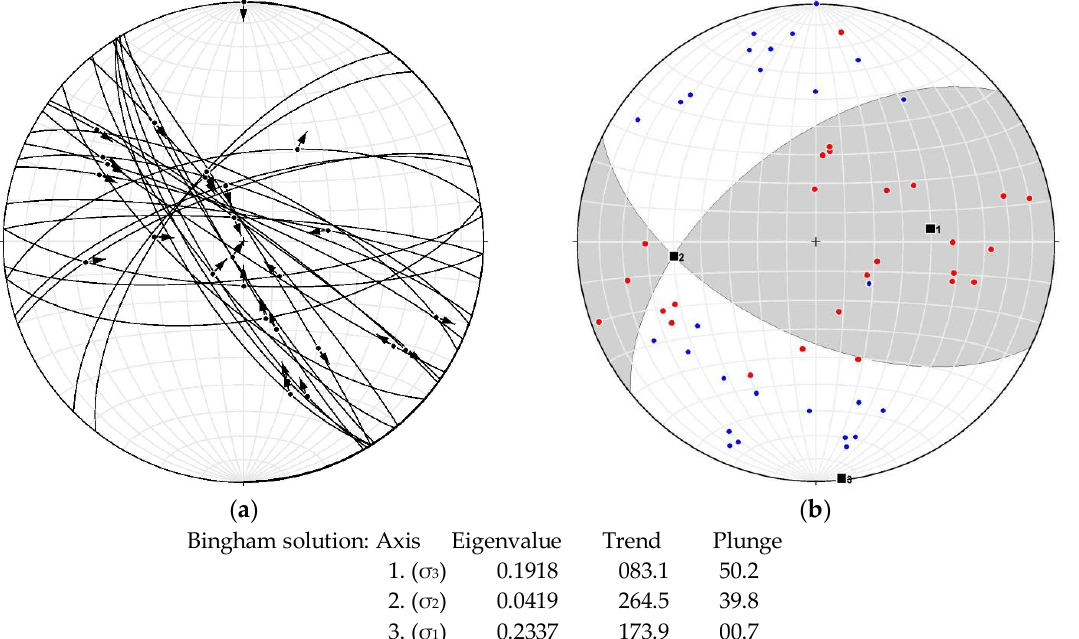
Figure 9. Orientation and paleo-stress analysis for D 6 shear zones measured in the Kukuluma and Matandani pits ( N = 27). ( a ) Plot of fault planes and lineations, with arrows pointing in the direction of movement of the hanging wall; ( b ) Fault plane solution (Bingham matrix solution) for the measured D 6 faults (compression dihedron in white; tension dihedron in grey). P axes are shown in blue, T axes in red. The Bingham solution shows north-south shortening with a near-horizontal σ 1 , and a dispersed distribution of the P and T axes, i.e., σ 2 and σ 3 are similar.